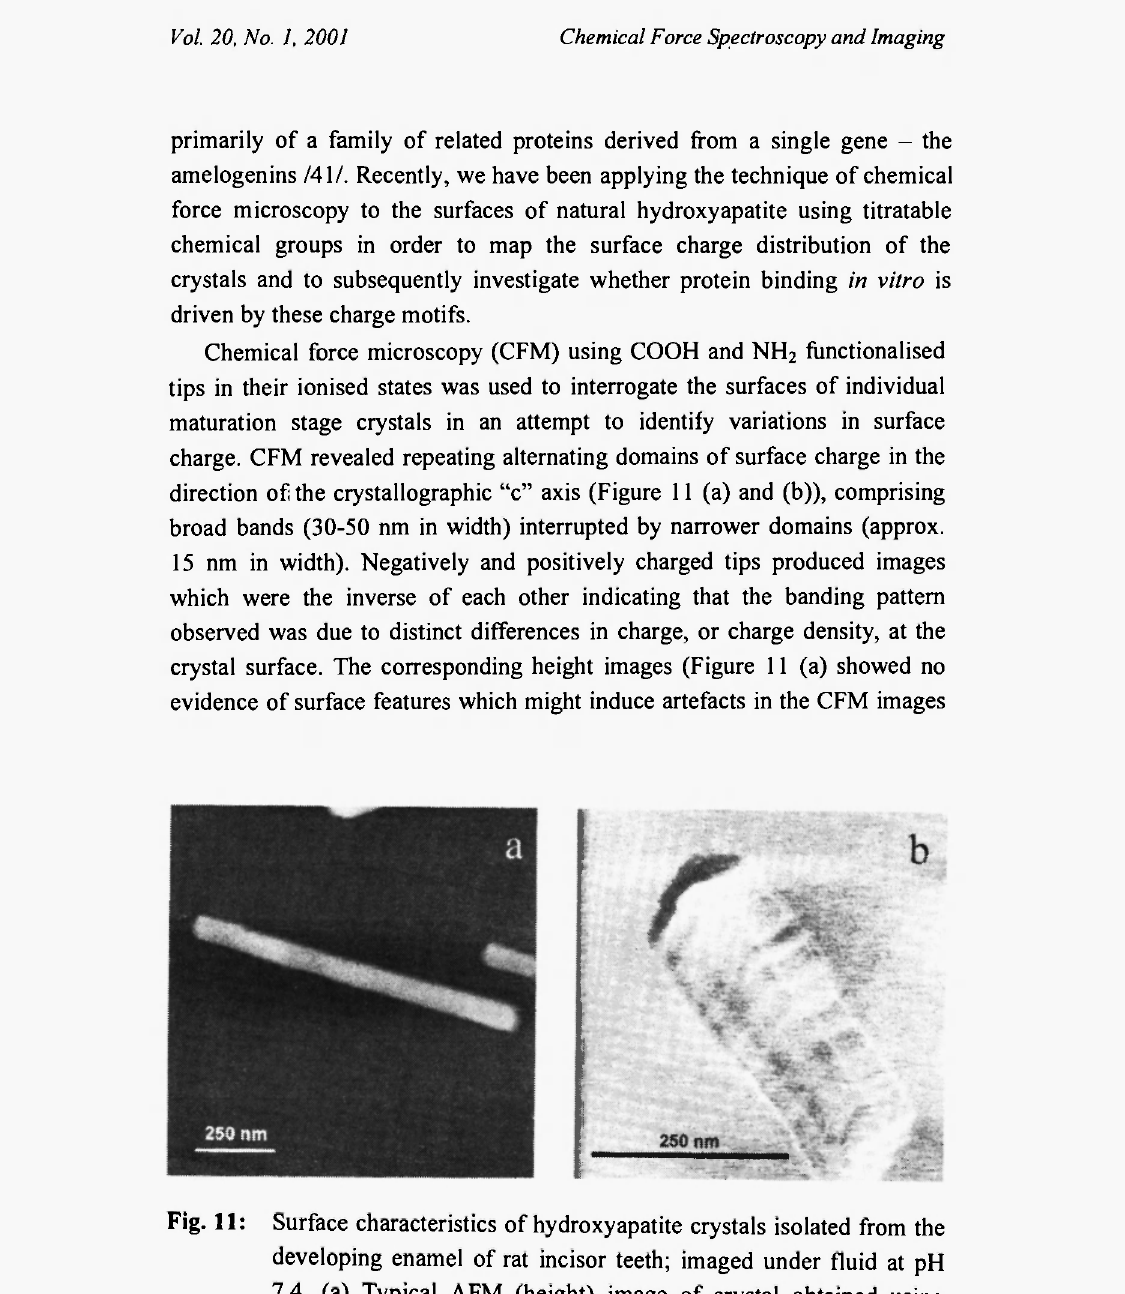
Fig. 11: Surface characteristics of hydroxyapatite crystals isolated from the developing enamel of rat incisor teeth; imaged under fluid at pH 7.4. (a) Typical AFM (height) image of crystal obtained using unmodified tip. Crystal surfaces are typically very smooth, (b) CFM image obtained in lateral force mode using carboxyl- modified tip. Bands of high and low friction, corresponding to alternating charge domains can be